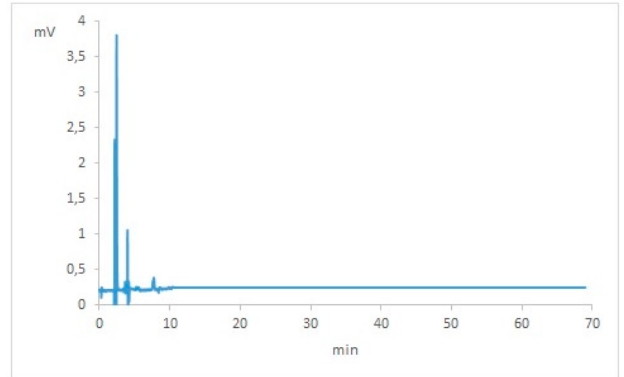
Figure A3. Chromatogram of no template control of the digestion reaction including S1 nuclease and its 1x reaction buffer.